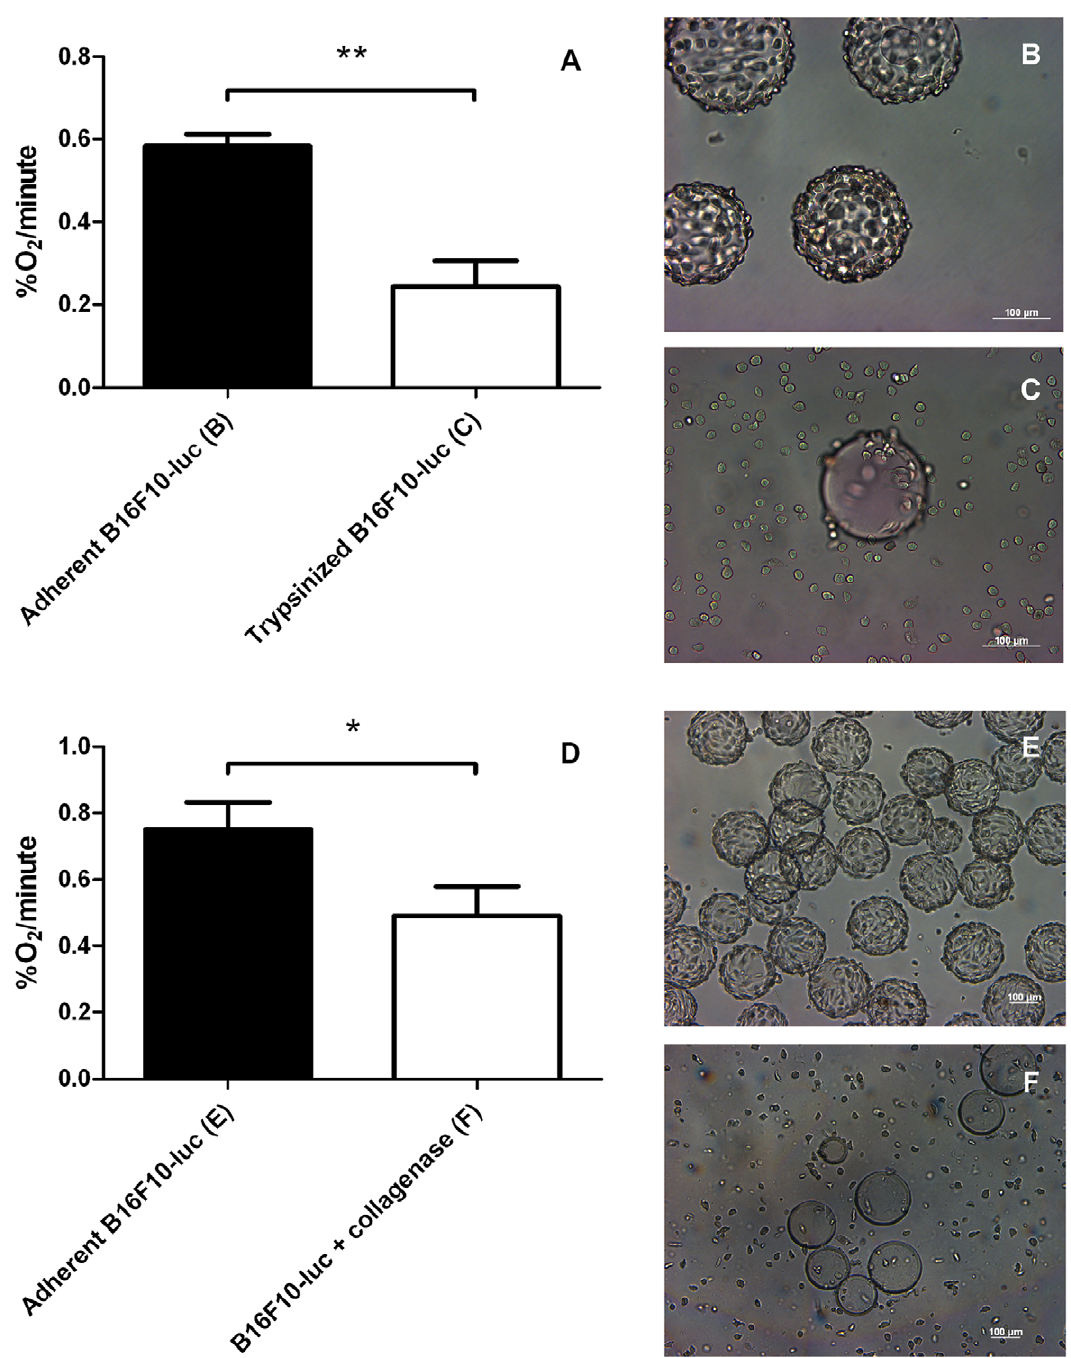
Figure 3. Effect of detachment procedures on B16F10-luc tumor cells. OCR values (%O 2 /minute) (A, D) of adherent B16F10-luc and detached B16F10-luc. Trypsinized (n=3) or collagenase group (n=4) show a decreased oxygen consumption rate compared to control groups (n=3 for A, n=6 for D). Results are statistically significant (** p , 0.01 for trypsinized cells, * p , 0.05 for B16F10-luc + collagenase). Pictures of each treatment are displayed next to the graphs. Trypsin treatment (C) or dissolving the coating of Cytodex 3 microbeads (F) result both in cell detachment while control cells (B and E) remain adherent. Data are expressed as means 6 SEM.